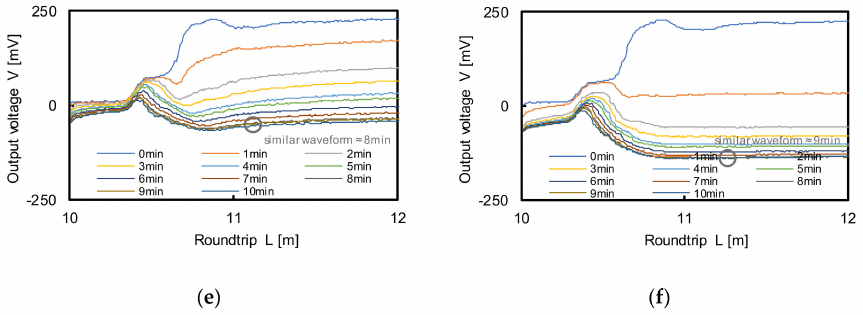
Figure 5. Measured TDR waveforms: ( a , b ) glass bead (GB); ( c , d ) Jumunjin sand (JS); ( e , f ) extracted soil from field (ES). The Dr denotes the relative density. Dr = 40% ( a , c , e ), Dr = 80 % ( b , d , f ).